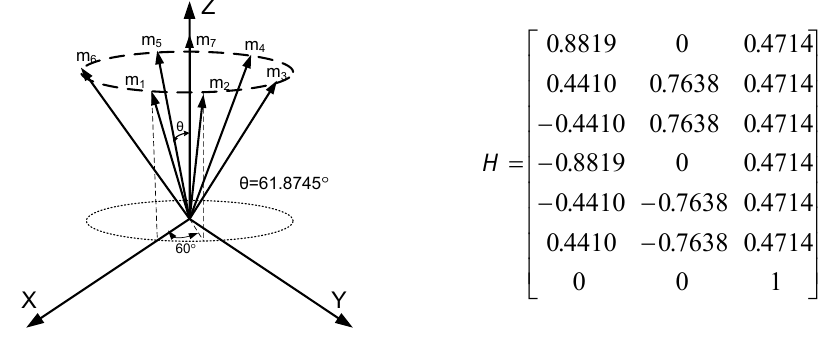
Figure 7. Configuration 2 with seven inertial sensors.